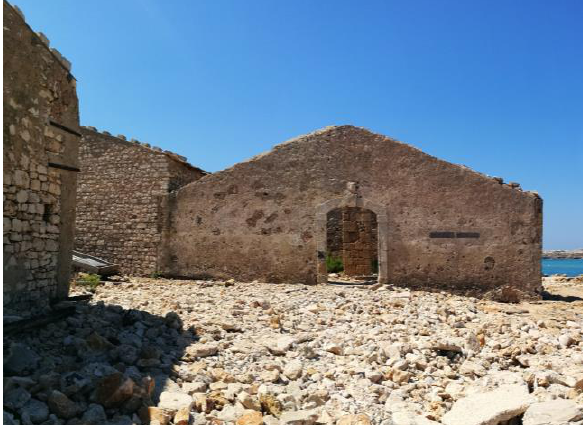
Figure 4. Buildings of the tonnara of Portopalo on Capo Passero